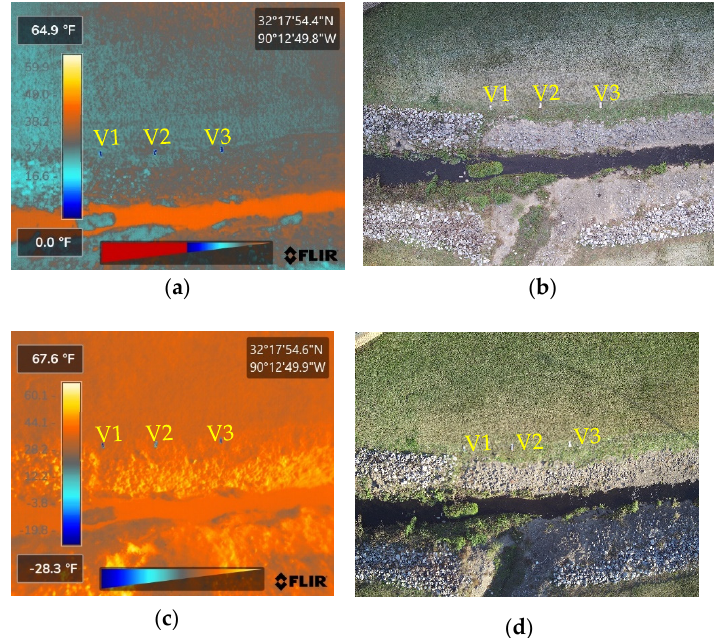
Figure 19. University slope UAV thermal and optical images at 100 ft. altitude. ( a , b ) Captured at dawn. ( c , d ) Captured at midday.